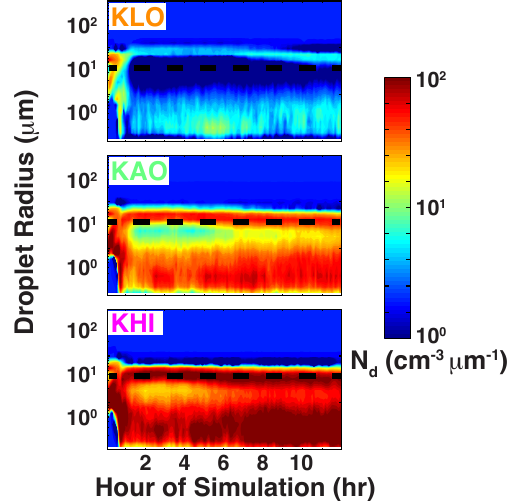
Fig. 14. Domain-averaged cloud-top size distributions for the KLO, KAO and KHI simulations at 5-min resolution. The dashed line in- dicates a radius of 10µm.